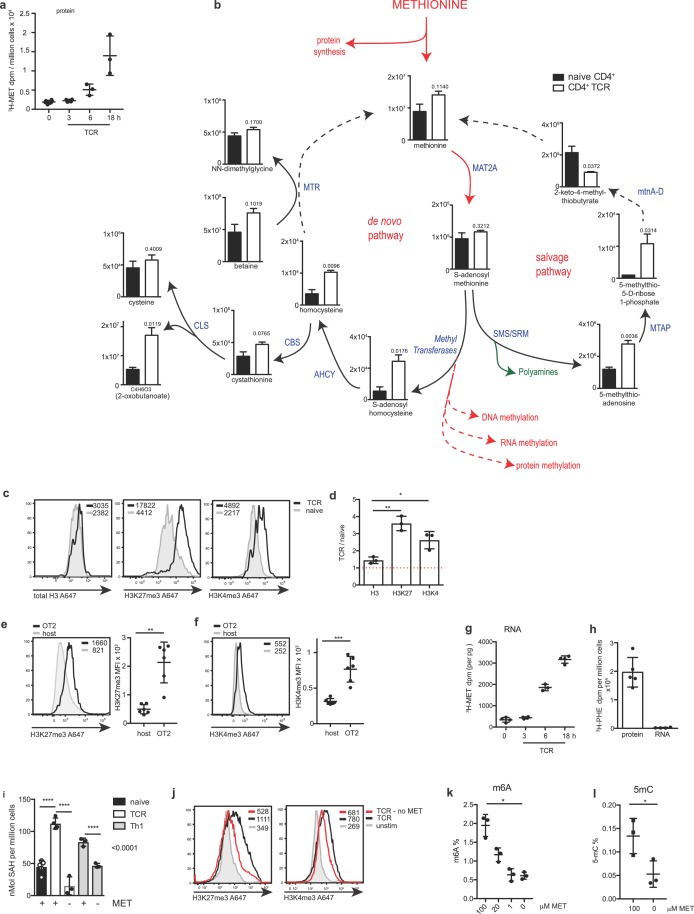
Methionine metabolism in T cells.(a) 3H radioactivity measured in TCA precipitated protein from isolated CD4+ T cells stimulated through the TCR (CD3/CD28) in the presence of 3H-methionine for the indicated times. (b) Metabolomic analysis of metabolites in the de novo pathway and the salvage pathway of the methionine cycle. The graphs show metabolite intensity derived from integrated peak areas of MS intensity from naïve CD4+ T cells and TCR-stimulated CD4+ T cells (CD3/CD28, for 16 hr). Enzymes are indicated adjacent to arrows (in blue). P values are indicated on each graph. Source data is available in Figure 2—source data 1. (c) The histograms show representative intracellular staining of total H3, trimethylated H3K27 (H3K27me3) or trimethylated H3K4 (H3K4me3) from IL7 maintained (unstimulated) or TCR-stimulated (CD3/CD28) CD4+ T cells for 18 hr. Geometric mean fluorescence intensities (MFI) are shown in the histograms. (d) The graph shows ratios of H3, H3K27me3 and H3K4me3 MFIs from TCR-stimulated (CD3/CD28) CD4+ T cells compared to unstimulated CD4+ T cells. (e, f) OT2 (CD45.1) cells were adoptively transferred into WT CD45.2 hosts. The hosts were immunised with NP-OVA/alum and the transferred OT2 cells were analysed after 3 days. The histograms (left) show representative intracellular staining of H3K27me3 (e) and H3K4me3 (f). Graphs (right) show ratios of H3K27me3 and H3K4me3 MFIs in activated OT2 CD4+ T cells compared to non-activated host CD4+ T cells 3 days post-immunisation. (g) 3H radioactivity measured in RNA extracted from isolated CD4+ T cells stimulated through the TCR (CD3/CD28) in the presence of 3H-methionine for the indicated times. (h) 3H radioactivity measured in protein or RNA extracted from CD4+ T cells stimulated in parallel to (g) in the presence 3H-phenylalanine for 18 hr. (i) Levels of SAH from unstimulated (naïve cells), TCR-stimulated (CD3/CD28, 18 hr) CD4+ T cells or IL2 maintained Th1 cells ± methionine for 18 hr. (j) The histograms show representative intracellular staining of total H3, trimethylated H3K27 (H3K27me3) or trimethylated H3K4 (H3K4me3) from IL7 maintained (unstimulated) or TCR-stimulated (CD3/CD28) CD4+ T cells±methionine as indicated (18 hr). (k) Percentage of RNA with m6A modification, as determined by ELISA, in Th1 cells cultured with decreasing methionine concentrations for 5 hr (as indicated). (l) Percentage of RNA with m5C modification, as determined by ELISA, in Th1 cells cultured ±methionine for 5 hr. (Error bars are mean ± s.d of: (a–d, i–l) three biological replicates (e–f) six biological replicates. (g,h) 4 (RNA) biological replicates and five biological replicates (protein). MFIs are indicated in the histograms, points on the graphs indicate biological replicates. (b, e, l) t -test; (d,i,k) One-way ANOVA; P= *<0.05, **<0.01, ***<0.001, ****<0.0001; Flow cytometry gating strategies are provided in Supplementary file 1).10.7554/eLife.44210.005Figure 2—source data 1.Spreadsheet containing the list of metabolite intensities derived from integrated peak areas of MS intensity from naïve CD4+ T cells (N1-3) and TCR-stimulated CD4+ T cells (S1-3).